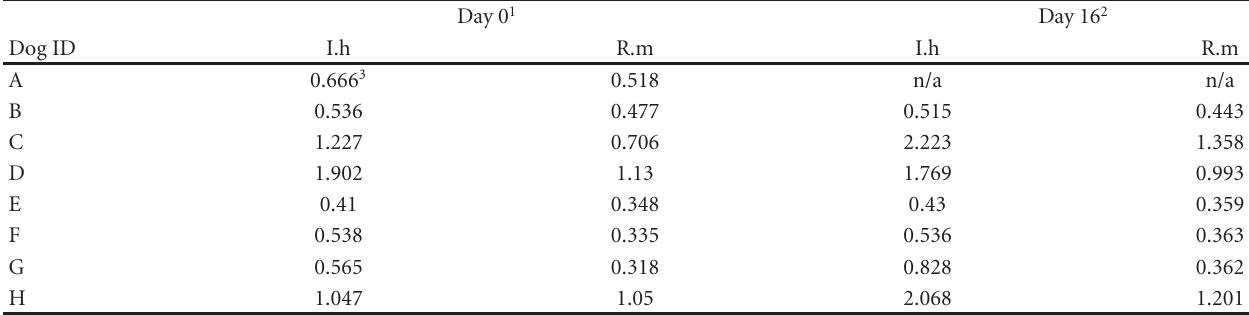
Table 1: Reactions of sera from dogs su ff ering from tick paralysis to Ixodes holocyclus (I.h) and Rhipicephalus ( Boophilus ) microplus (R.m) antigen in ELISA.